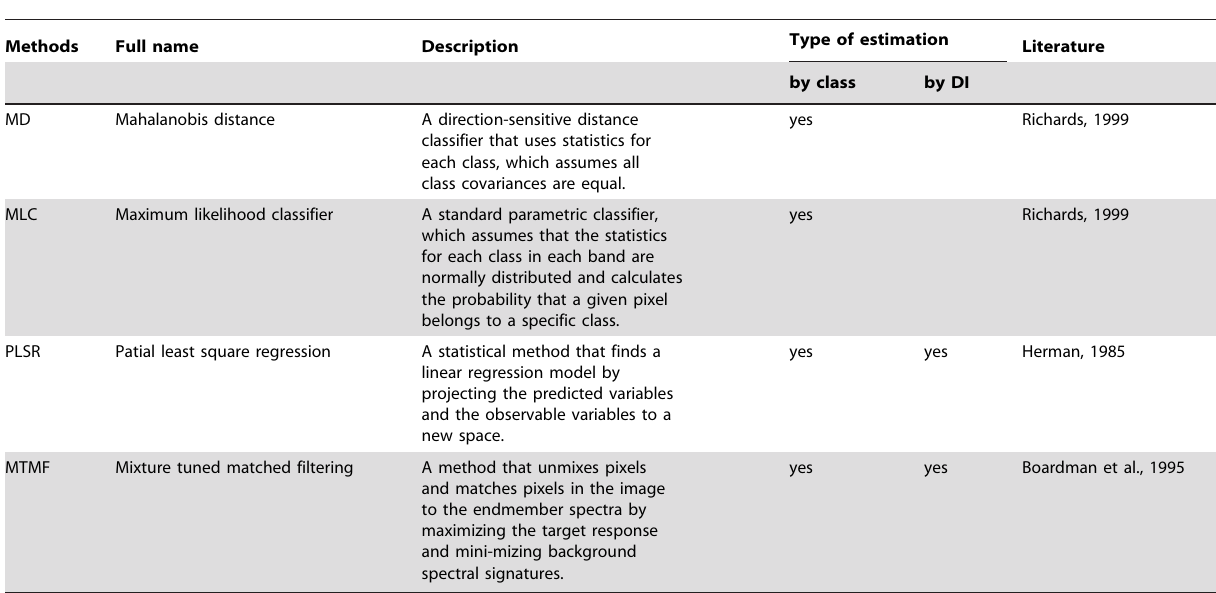
Table 3. Characteristics of methods used in this study for disease